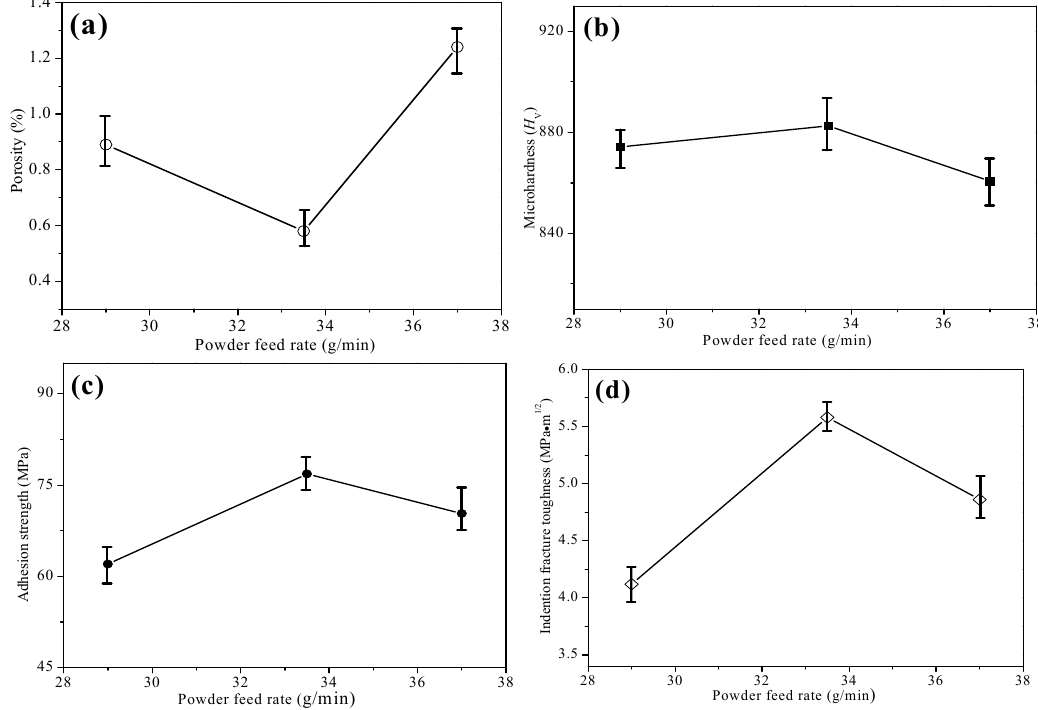
Figure 3. Effect of powder feed rate on ( a ) porosity, ( b ) microhardness, ( c ) adhesion strength and ( d ) indention fracture toughness of Cr 3 C 2 ‐ 25NiCr coating.